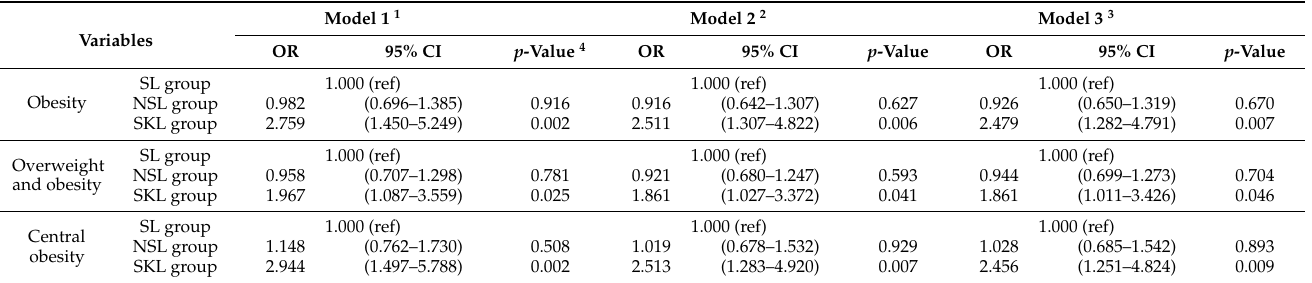
Table 4. Odds ratios of obesity according to the lunch type among children and adolescents in South